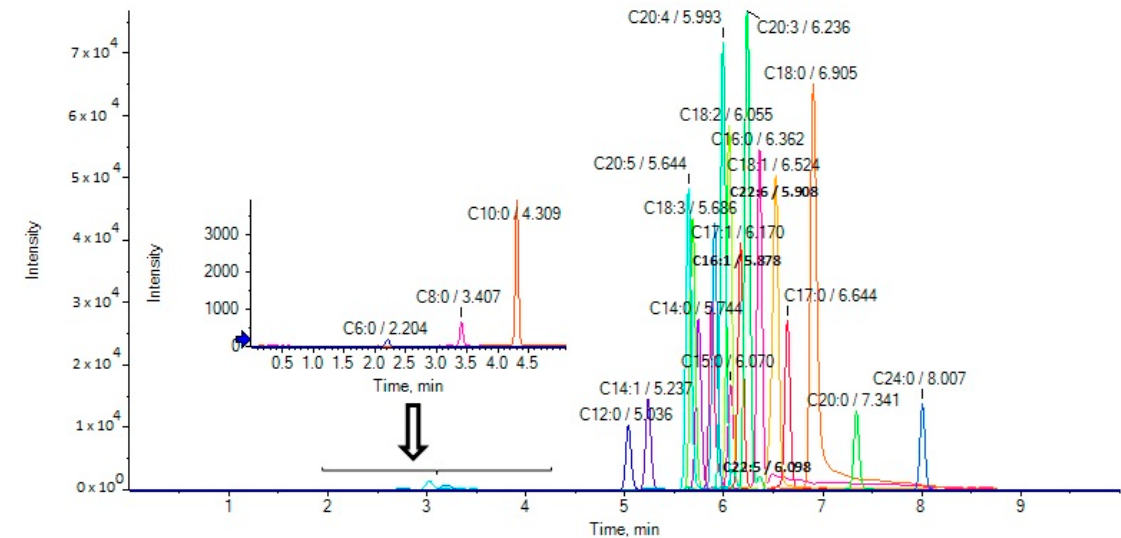
Figure 1. Extracted ion chromatograms (EICs) of fatty acids in a standard solution (500 ng / mL).